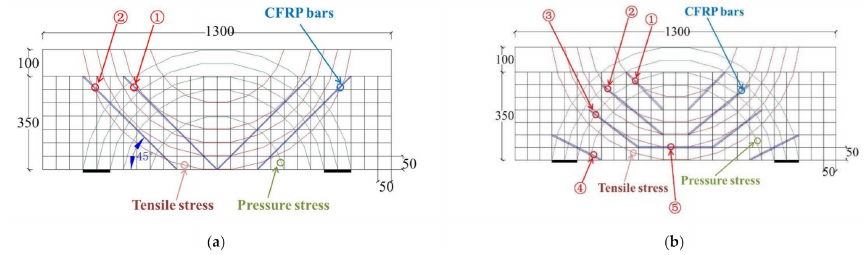
Figure 19. Scheme I and Scheme II: ( a ) Simple reinforced scheme I distribution of CFRP bars; ( b ) Optimized reinforced scheme II distribution of CFRP